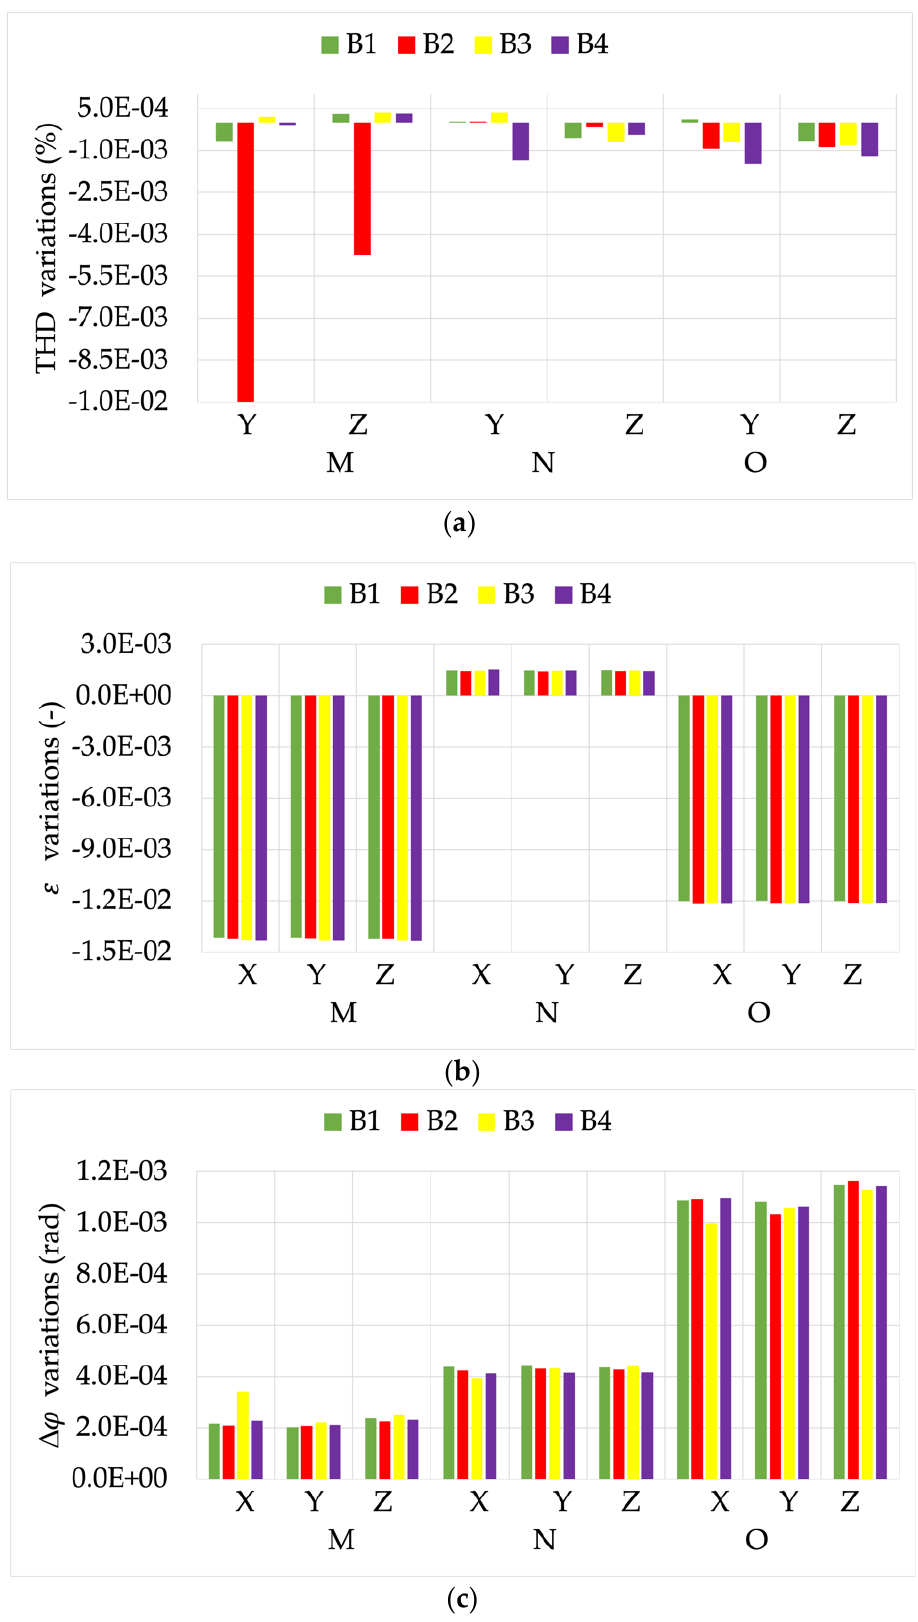
Figure 14. ( a ) THD, ( b ) 𝜀 , and ( c ) ∆𝜑 variations, from the tests vs. burden and position, for RC R1.